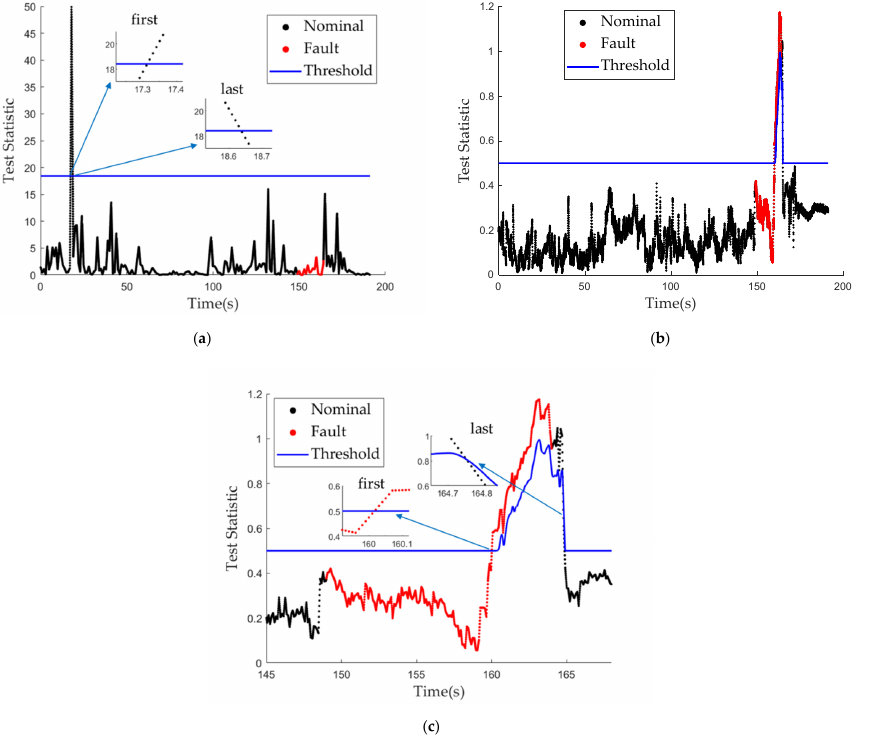
Figure 13. Fault detection results of the residual chi-square test and the proposed algorithm. ( a ) The fault detection result of the residual chi-square test. ( b ) The LiDAR aided real-time fault detection result. ( c ) Local magnification for fault detection of proposed algorithm. Table 2. The fault detection performance of the chi-square test and the proposed algorithm. The Residual Chi-Square Test Proposed Algorithm The period of the fault From 149th to 164th s Time of the first detected fault